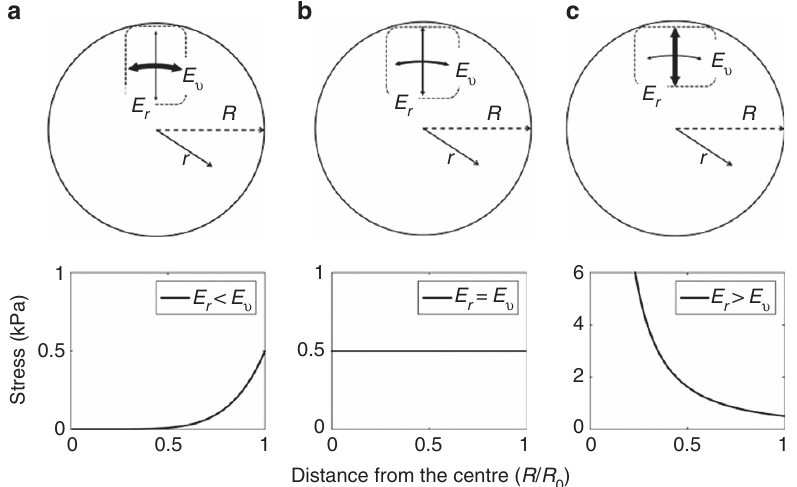
Figure 6 | Stress distribution in dependence of the cellular anisotropy—theoretical model. Graphical representation of the anisotropy within spheroids with ( a ) cells are softer in the radial direction ( E r ) than tangentially ( E n ), ( b ) cells are mechanically isotropic and ( c ) cells are stiffer in the radial direction. Below: radial stress profile along the radius computed with the theoretical model of Delarue et al . For ( a ) stress decreases towards the core, for ( b ) stress is constant, and for ( c ) stress increases towards the